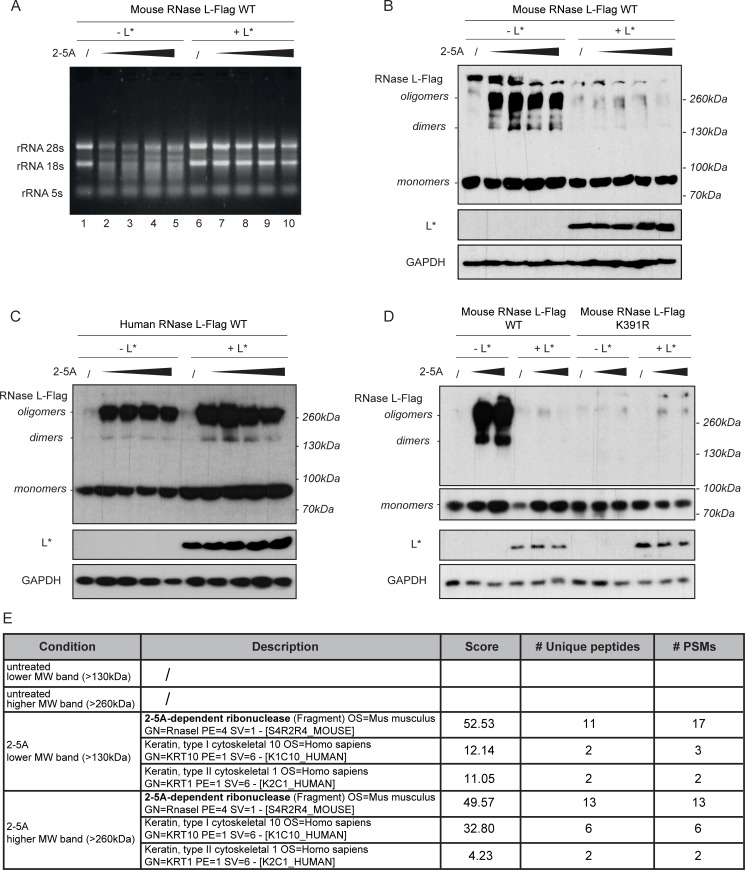
L* inhibits mouse RNase L dimerization and oligomerization.C-terminal Flag-tagged RNase L (RNase L-Flag) and L* were overexpressed in 293T cells by transfection. Cells lysates were divided into samples where RNase L dimerization was induced by adding increasing concentrations of 2-5A. Dimers/oligomers were crosslinked using DSS. A. RNA was extracted from lysates (same samples as in B) and analyzed on agarose gel electrophoresis as a control for RNase L activation. 2-5A concentrations: 0.25, 0.5, 1 and 2μM ATP equivalent. B. The upper panel shows the detection by immunoblot of WT mouse RNase L-Flag monomers, dimers and oligomers using an anti-Flag antibody. Lower panels show detection of L* and GAPDH used as a loading control. 2-5A concentrations: 0.25, 0.5, 1 and 2μM ATP equivalent. C. The upper panel shows the detection of WT human RNase L-Flag monomers, dimers and oligomers using an anti-Flag antibody. Lower panels show detection of L* and GAPDH. 2-5A concentrations: 0, 2, 4 and 8μM ATP equivalent. D. Dimerization-defective (K391R) mouse RNase L was used as a dimerization control. The upper panel shows the detection of RNase L-Flag monomers, dimers and oligomers using an anti-Flag antibody. Lower panels show detection of L* and GAPDH. 2-5A concentrations: 0.5 and 2μM ATP equivalent. Reproducible results were obtained in 2 independent experiments. E. Mass spectrometry analysis of high molecular weight RNase L complexes. Proteins for which 2 or more unique peptides were detected, with a false discovery rate below 5%, are listed in the table. # PSMs: number of peptide spectrum matches. /: no peptide detected above threshold.